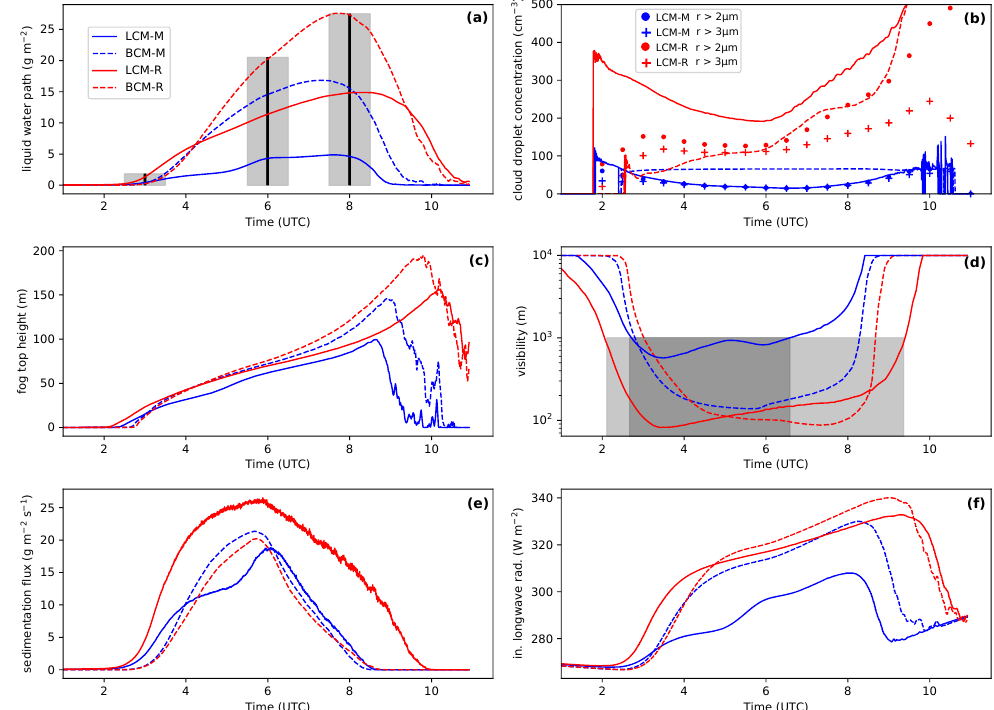
Figure 2. Temporal evolution of liquid water path ( a ), droplet number concentration averaged over the fog layer ( b ), fog top height ( c ), visibility at 2m height ( d ), sedimentation rate at the surface and surface ( e ) incoming longwave radiation ( f ). The vertical line and bars in ( a ) mark the time step and the range for the size distribution in Figure 4. The shaded areas in ( d ) shows the time frame where fog is present (applying the definition visibility < 1000m) regarding LCM-M and